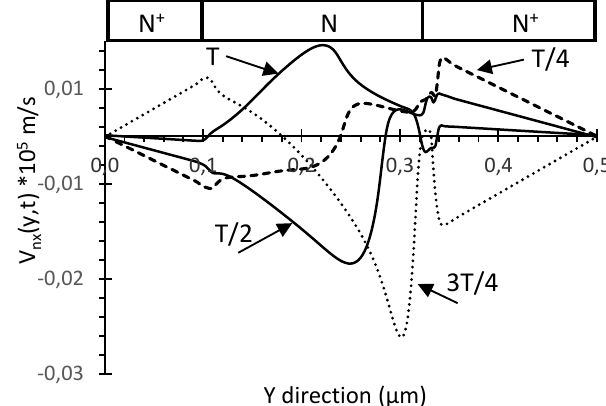
Figure 8: Y direction space-time evolution of the x direction component of the electron evolution at y=130 µm during a RF